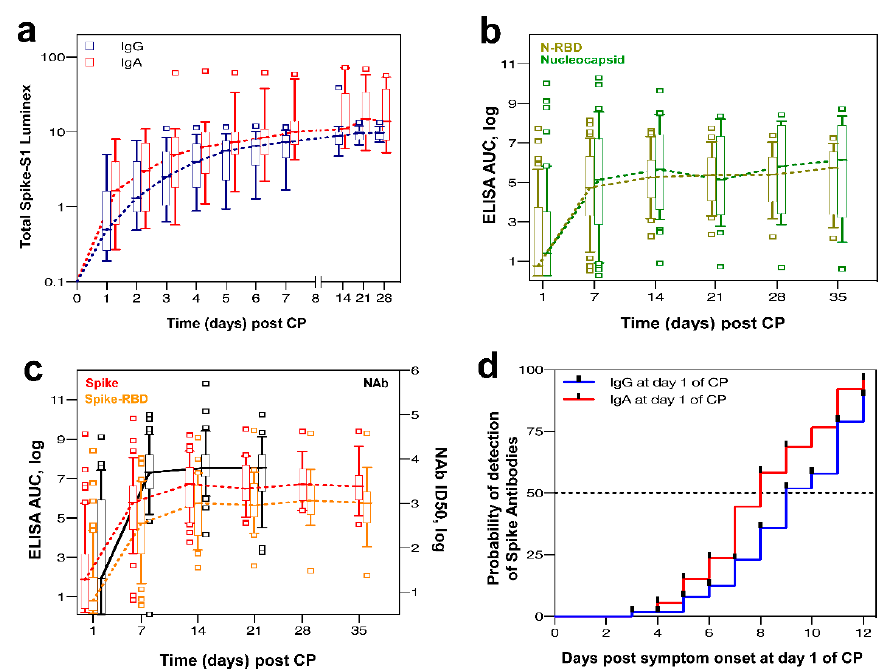
Figure 2. (a ) Trend of anti-S1 IgG and IgA antibody levels in the recipients following CP infusion. ( b ) Trends of Nucle- ocapsid and N_RBD in the recipients following CP Infusion. ( c ) Trend of Spike, Spike_RBD and Nab in the recipients following CP infusion. ( d ) Probability of detection of anti-S1 IgG and IgA in the recipients at day 1 of CP infusion post symptom